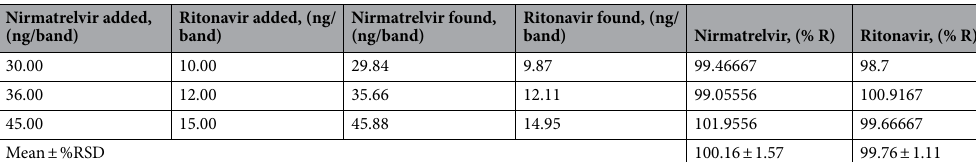
Table 3. Determination of nirmatrelvir and ritonavir in the laboratory prepared